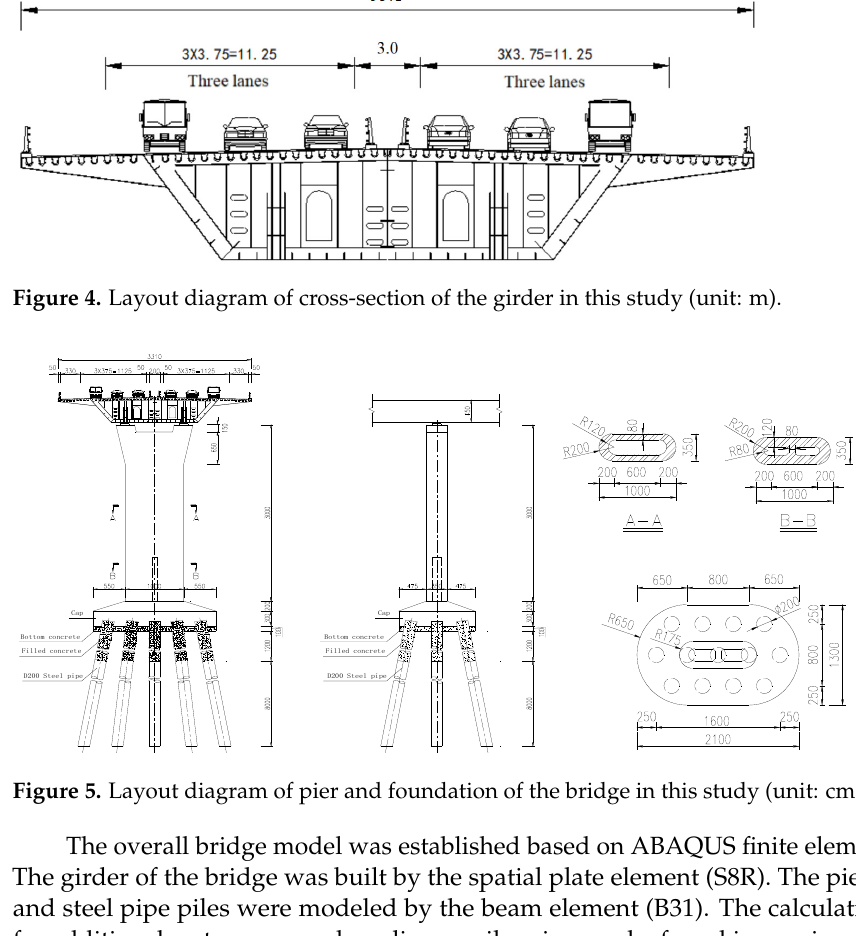
Figure 4. Layout diagram of cross ‐ section of the girder in this study (unit: m).